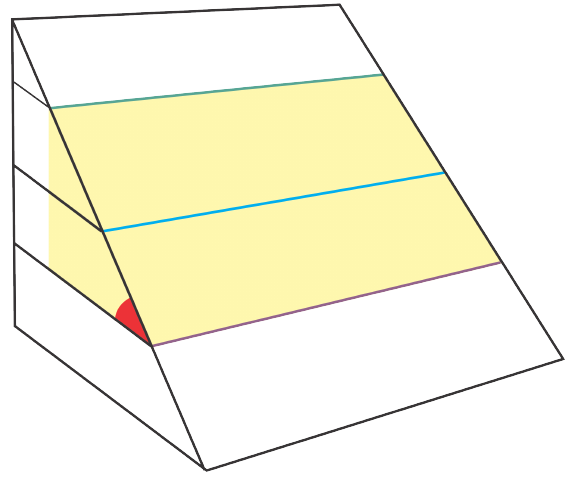
Figure 7. Incidence angle